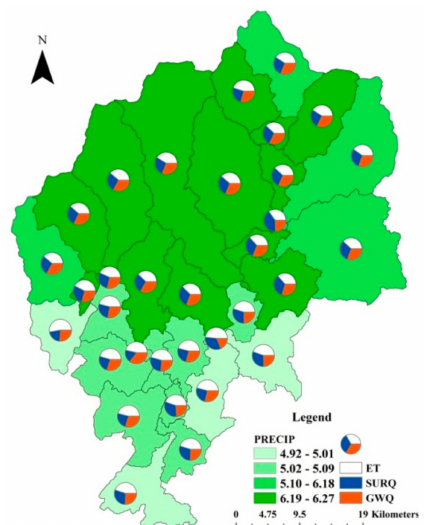
Figure 8. Spatial distribution of actual evapotranspiration (ET), surface runoff, groundwater discharge, and precipitation for the study